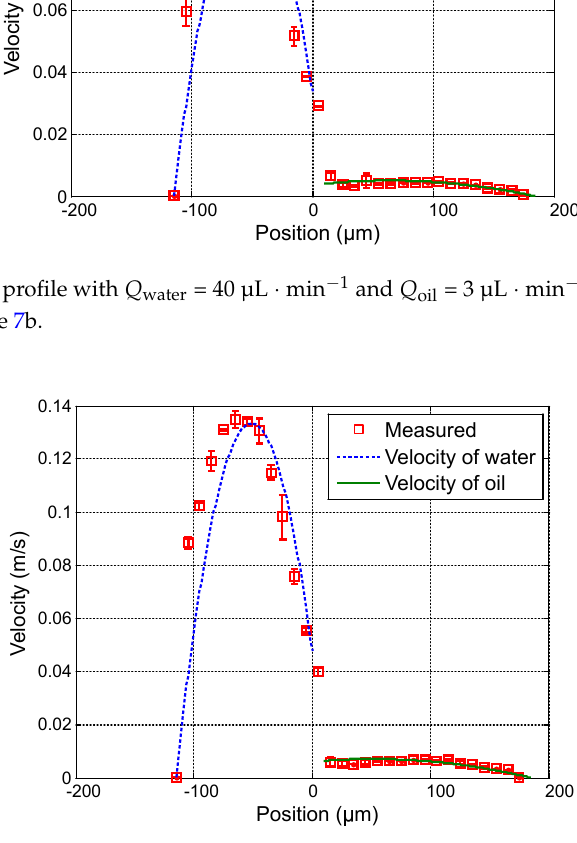
Figure 9. Measured profile with Q water = 60 µL · min − 1 and Q oil = 4.5 µL · min − 1 . The reference image is the same as Figure